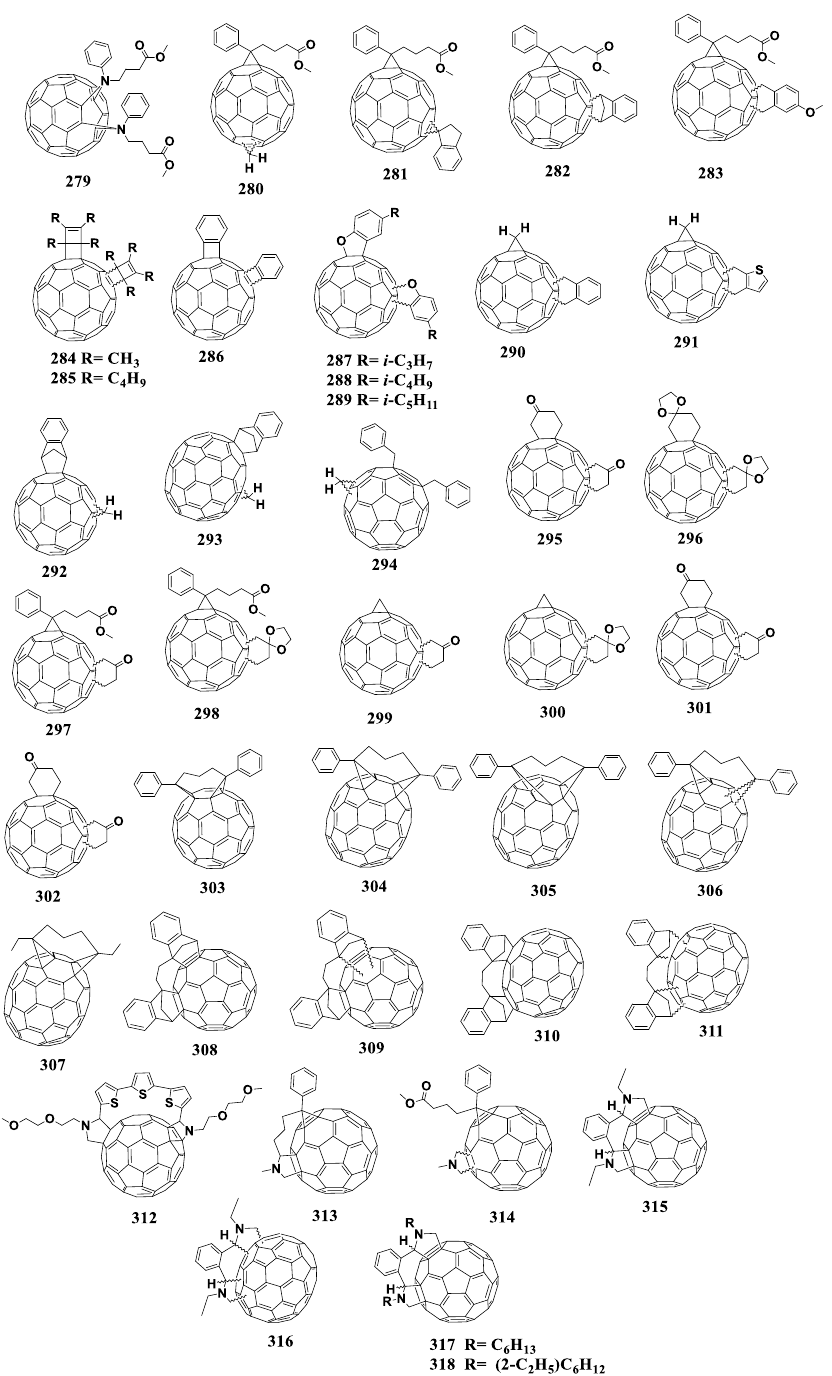
Figure 22. Molecular structures of fullerene bis(adducts) 279 – 318 with reduced electron affinity. In the work of Kim et al., bis(azafulleroid) 279 was obtained as a result of the [2+3]cy- cloaddition reaction of fullerene with the corresponding azide [205]. Note that, in contrast to classical bis(adducts) characterized by a chaotic distribution of substituents over the fullerene skeleton, in this case, only one compound containing organic addends located in close proximity to each other was formed. The first half-wave potential of compound 279 shifted by 30 mV to the cathodic region against [60]PCBM. The V OC of solar cells based on compound 279 increased by 110 mV as compared to the reference system, whereas other characteristics appeared to be quite